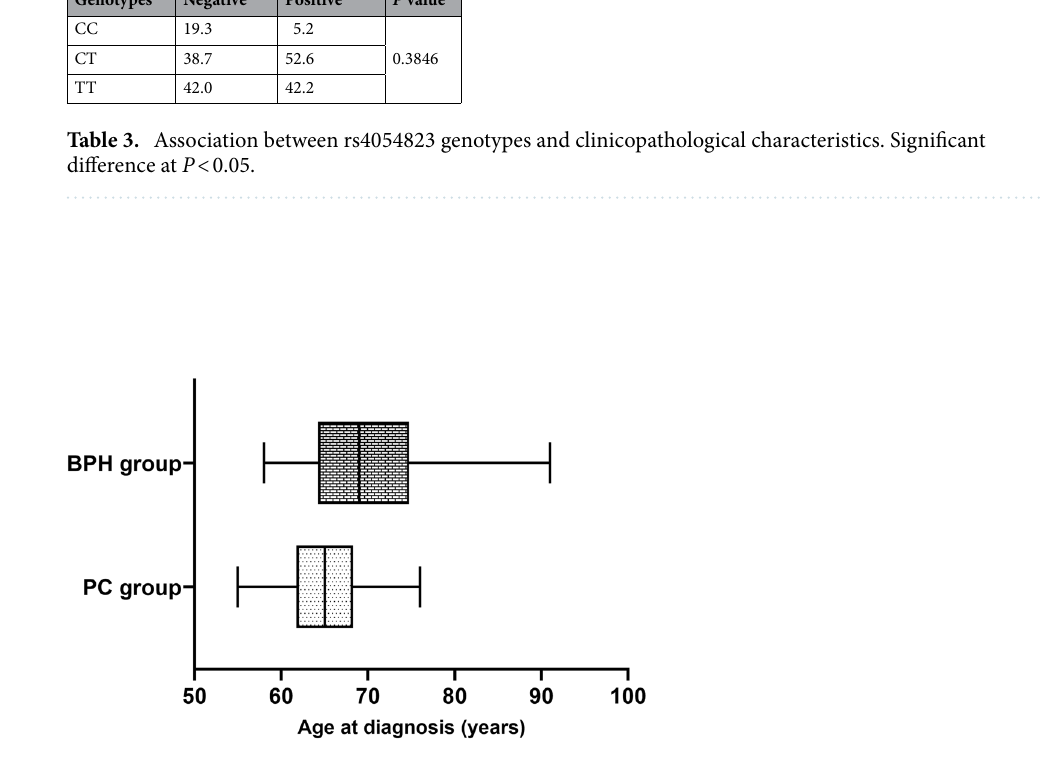
Figure 1. Differences between age at diagnosis in the PC and BPH